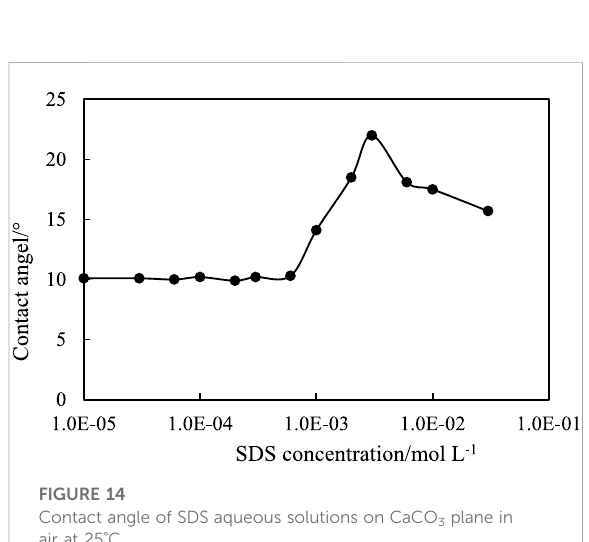
FIGURE 13 Adsorption isotherms of SDS at the CaCO 3 nanoparticle/ water interface at 25 ° C.